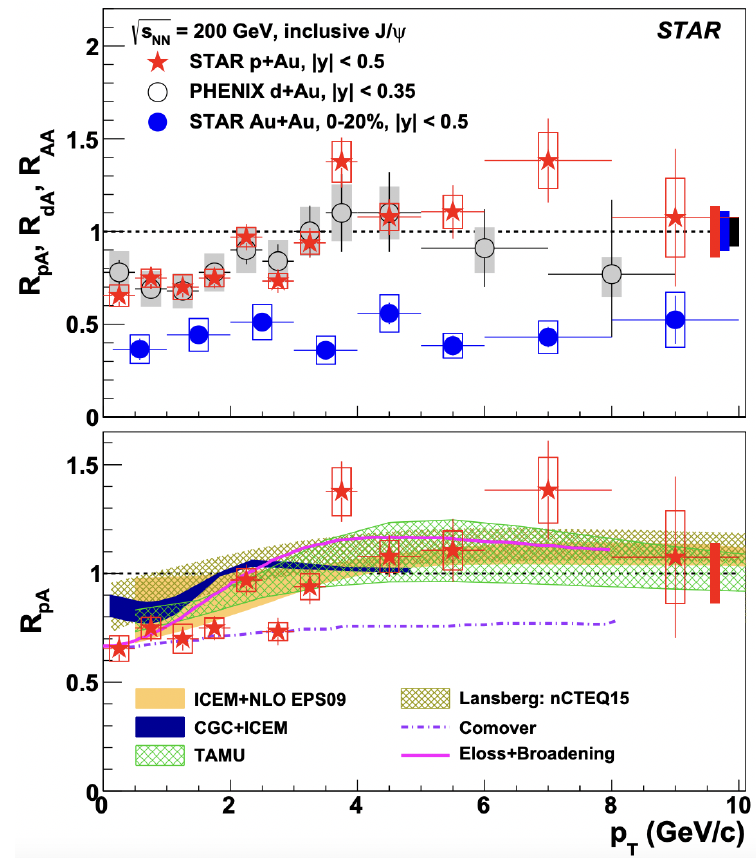
Figure 11. The J / ψ nuclear modification factor is shown as a function of p T in p + Au, d + Au, and Au + Au collision systems at mid-rapidity [63]. The red (blue) data points represent STAR measurements in p + Au (Au + Au) collision systems, while the open data points represent PHENIX measurements in d + Au collisions. The data are compared with different Monte Carlo calculations described in the text. Reprinted with permission from